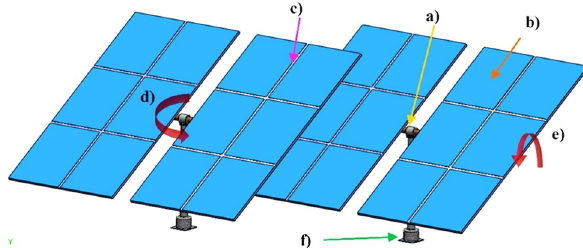
Figure 1: Heliostat structure and main components: ( a ) support for mirror base, ( b ) re fl ective surfaces, ( c ) re fl ective surface support, ( d ) rotation axis, ( e ) inclination axis, and ( f ) support base.